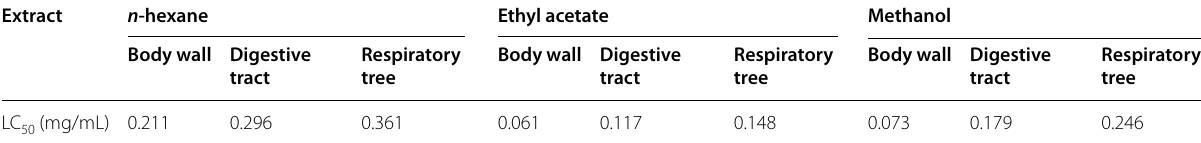
Table 2 The toxicity effects of extracts from sea cucumber S. herrmanni against barnacle A. amphitrite larvae Extract n ‑hexane